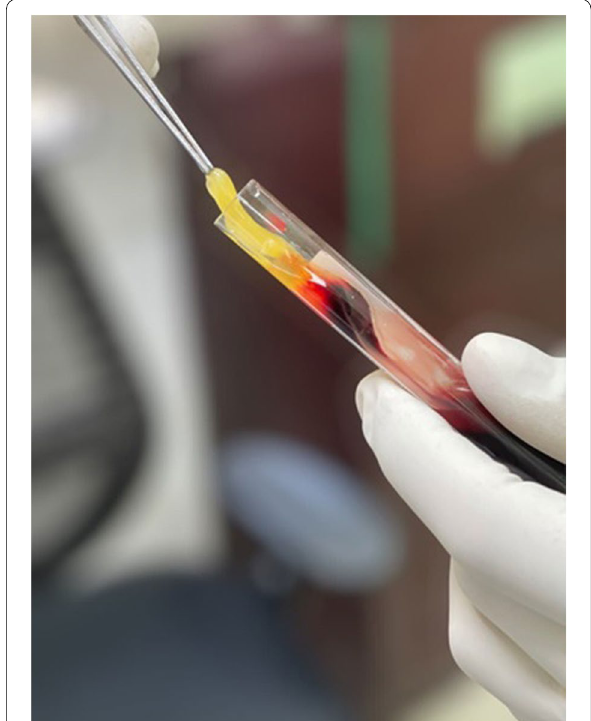
Fig. 3 Platelet-rich fibrin (PRF) extracted for